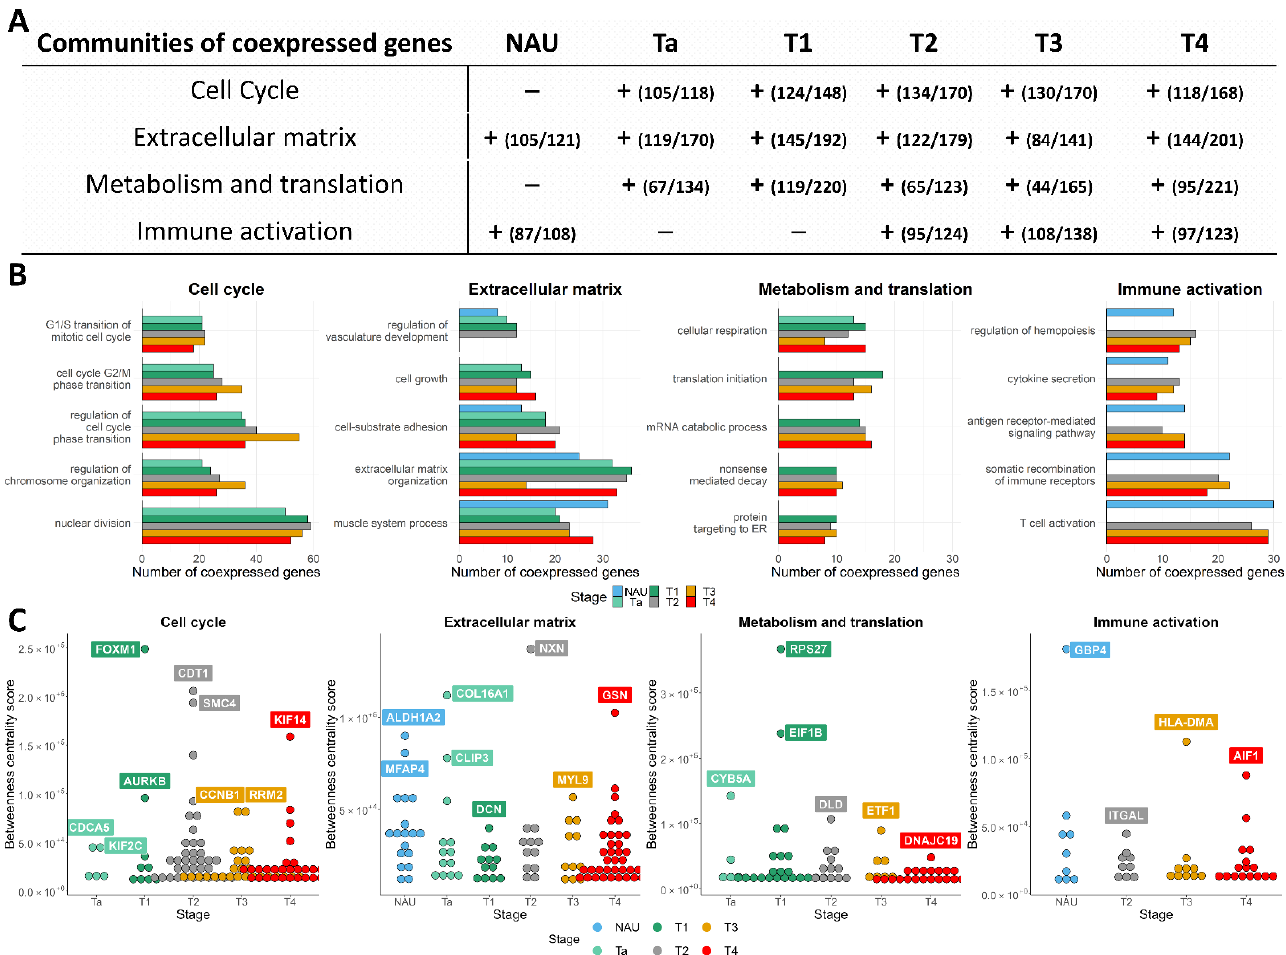
Figure 3. Biological process analysis of the largest (in size) co-expressed communities identified in each BLCA stage network: ( A ) Coherent communities identified and characterized across the non-malignant adjacent urothelium (NAU) and disease stages. The presence of a community is indicated by the + symbol. Numbers in parentheses show the fraction of genes with GO Biological Process annotation relevant to the community, with respect to the total number of genes found to be co-expressed in the community. ( B ) Bar plots of the most significantly enriched biological processes per community, depicting the number of co-expressed genes for each. ( C ) Hub genes identified across the studied conditions based on the betweenness centrality scores ( y -axis).